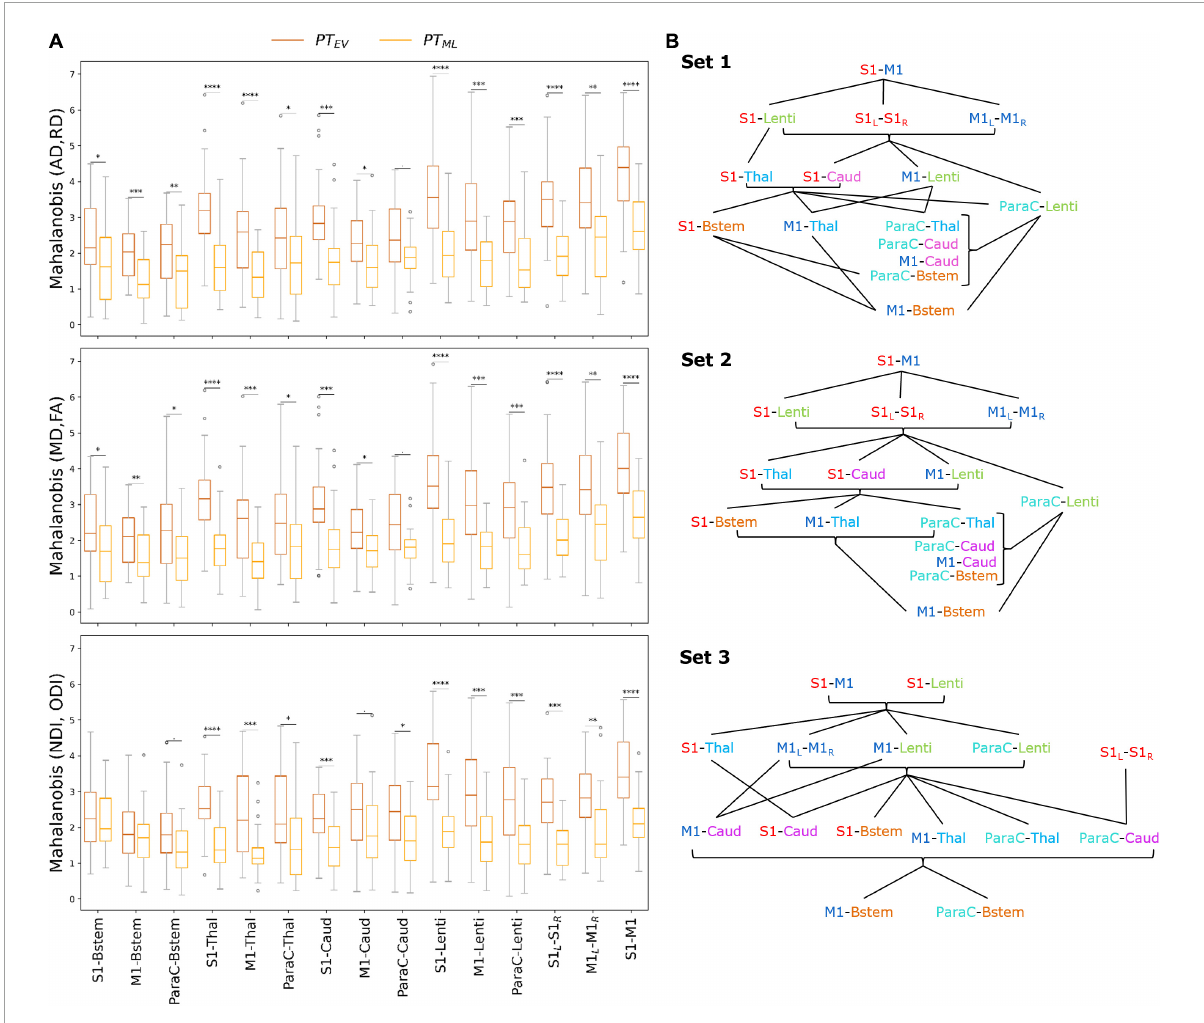
FIGURE4 (A) Multi-metric Mahalanobis distance across tracts and PT subgroups (PT EV and PT ML with FT controls as reference) at TEA. The smaller the distance, the less the microstructural profile of the PT infant differs from the FT reference group. Note that the effect of prematurity is globally smaller for PT ML than for PT EV infants across the studied SM tracts. Significances are results of the comparison of Mahalanobis distances (PT EV vs PT ML ) with unpaired t -tests ( p -values corrected for multiple corrections) for each set and each tract. For visualization purposes, outliers (mean ± 3SD) were removed (6 points for PT EV , 3 for PT ML infants). (B) Order of the SM tracts in the PT EV subgroup based on the Mahalanobis distance per metrics set (higher values on the top), highlighting the differential effect of prematurity on SM tracts microstructure. The lines represent the significant differences between tracts according to paired t -tests (corrected for multiple comparisons) over the PT EV group (for visualization purposes, the statistical threshold was relaxed to p < 0.1). Metrics sets: 1 (AD, RD); 2 (MD, FA); 3 (NDI, ODI). Refer to Figure 1 legend for ROIs color code and